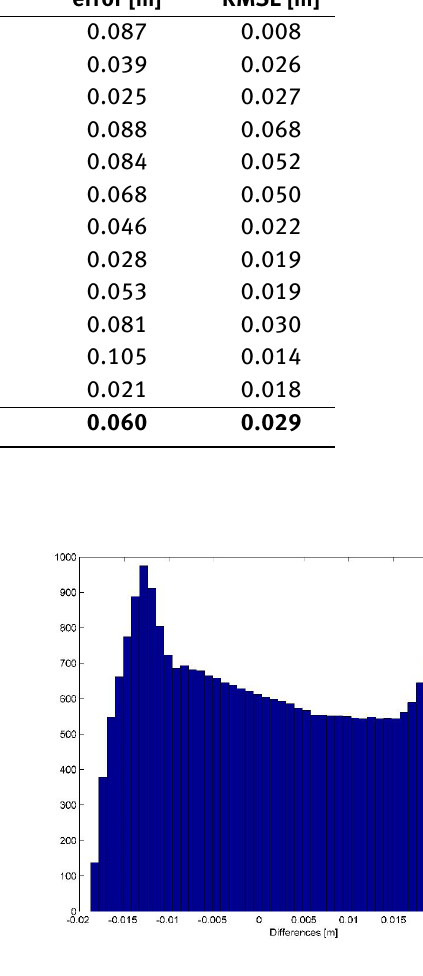
Figure 11: Residuals histogram between the fitted surface for the GCG2011 geoid heights and the approximately calculated geoid